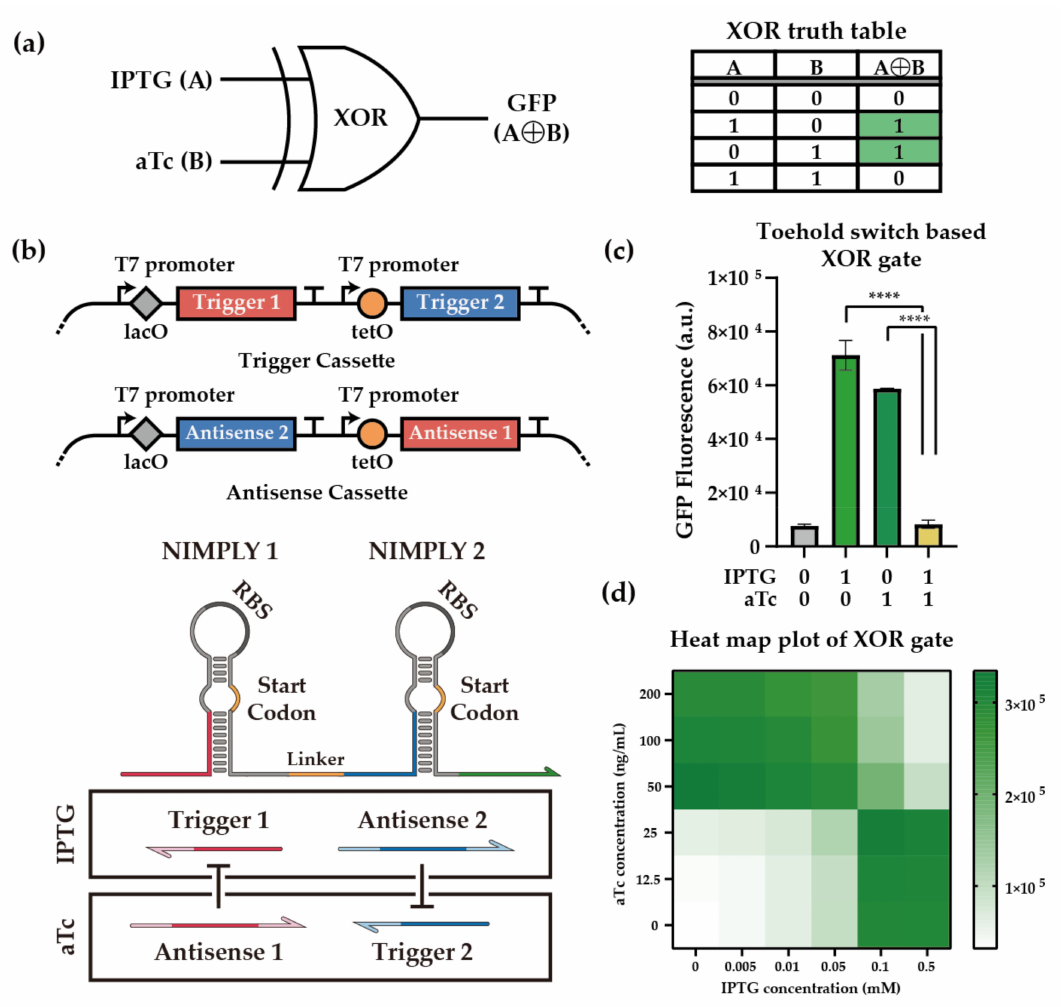
Figure 3. Toehold-switch-based XOR gate. ( a ) Schematics of XOR gate configuration. IPTG and aTc were used as input signals A and B for the XOR gate, and the output signal was visualized through GFP fluorescence. The truth table of the XOR gate indicated the ON and OFF states of the XOR gate depending on the combination of inducer molecules. ( b ) Genetic blueprint of trigger and antisense cassettes and schematics of the XOR gate. Lac operator was placed upstream of T1 and A2, and Tet operator was placed in front of T2 and A1. The optimized extended overhangs were used. ( c ) Performance of toehold-switch-based XOR gate. T7 RNA polymerase was induced with the pretreatment of 1% ( w / w ) arabinose in E. coli BL21 AI strain. XOR gate components were induced by 0.5 mM IPTG and 100 ng/mL aTc. GFP fluorescence was measured via flow cytometry. Cellular autofluorescence was subtracted in all cases. Autofluorescence level was measured from cells not bearing a GFP-expressing plasmid. Statistical analysis was performed to compare each state of the XOR gate. (Two-tailed Student’s t -test; **** p < 0.0001; Error bars indicate ± SD from three biological replicates) ( d ) Heat map plot of XOR gate output. The color scale was ranged between the minimum and maximum values of the XOR gate output. IPTG and aTc were treated in gradient concentration as described in the table. Each point of the heat map indicates the median value of three